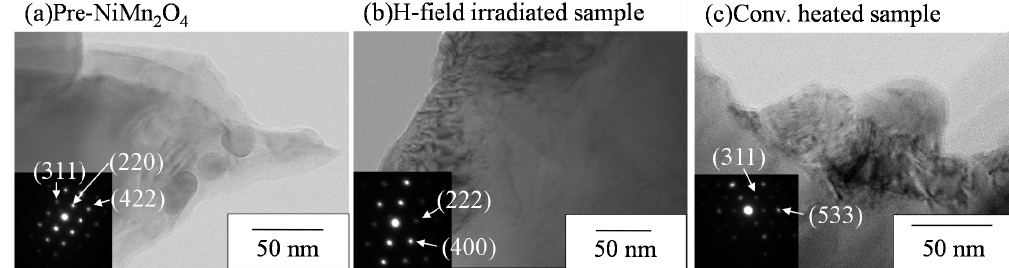
Figure 3. TEM images and electron-diffraction patterns of synthesized NiMn 2 O 4 . ( a ) Pre-NiMn 2 O 4 ; ( b ) H-field irradiated sample; ( c ) Conv. heated sample.